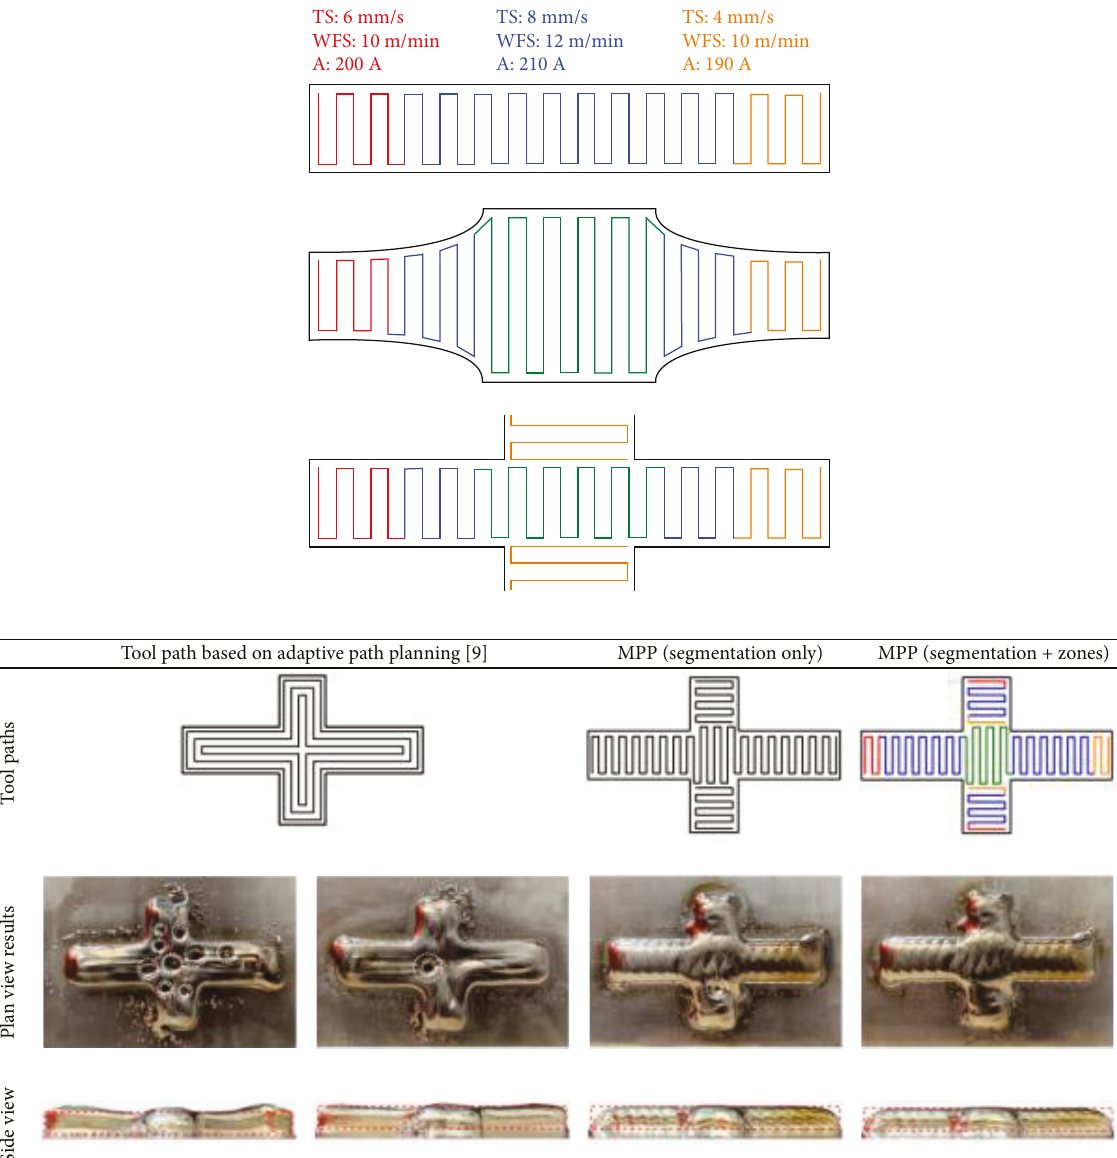
Figure 24: Circles indicate keyhole defects; the bounding boxes indicate the profile of the target